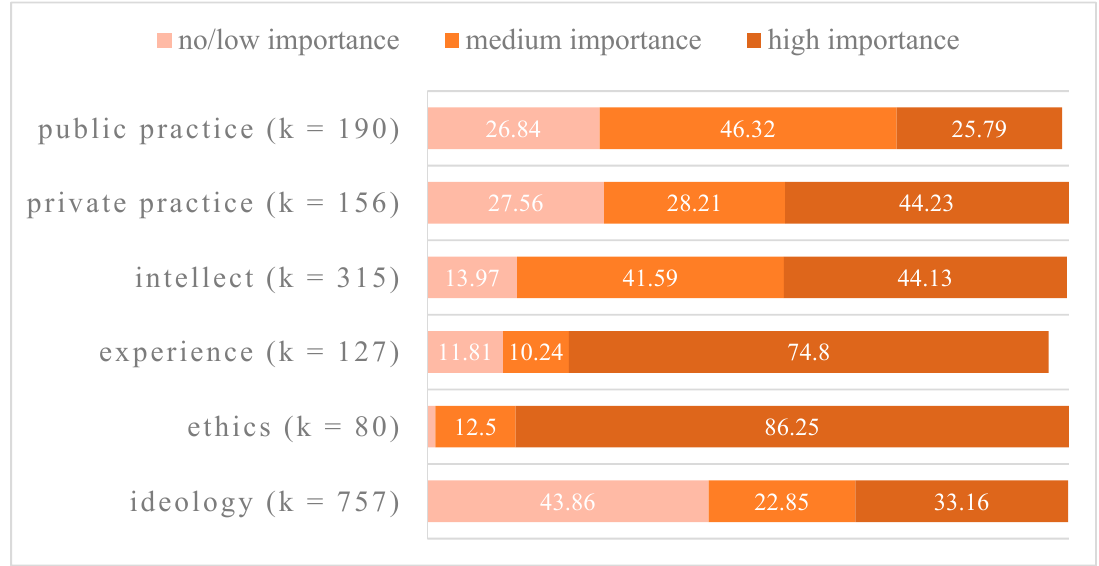
Figure 3. Results of the contingency analysis, displaying relative frequencies of the three levels of importance to the dimensions. Note. Public practice k = 2 n.a., intellect k = 1 n.a., ideology k = 1 n.a. Ethics are reported with a no/low importance in only 1.25% of the codes.